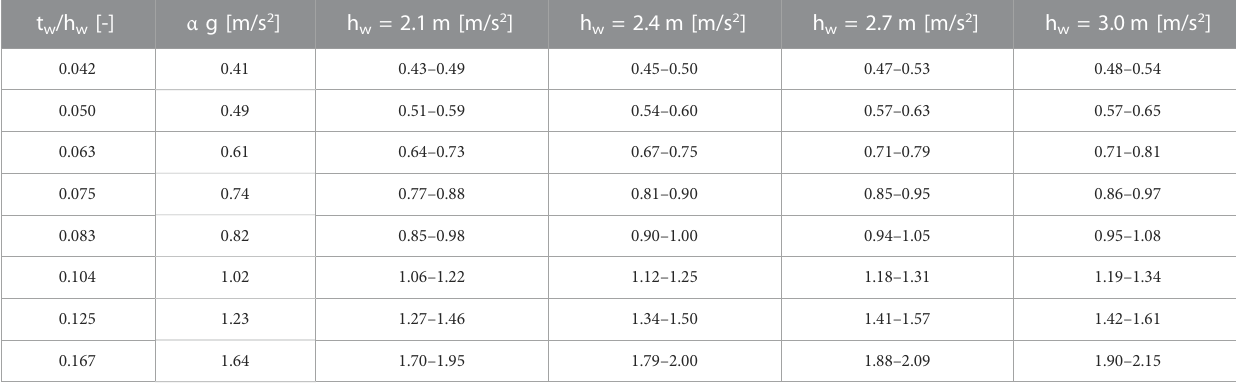
TABLE 4 Results of the NLTHA for different wall heights by keeping the wall aspect ratio constant. The fi gures provide considered ultimate ground accelerations (mean 12 TH > 0.4 · 2/3 · t w ) for damping ratios between 3% and 5%. t w /h w